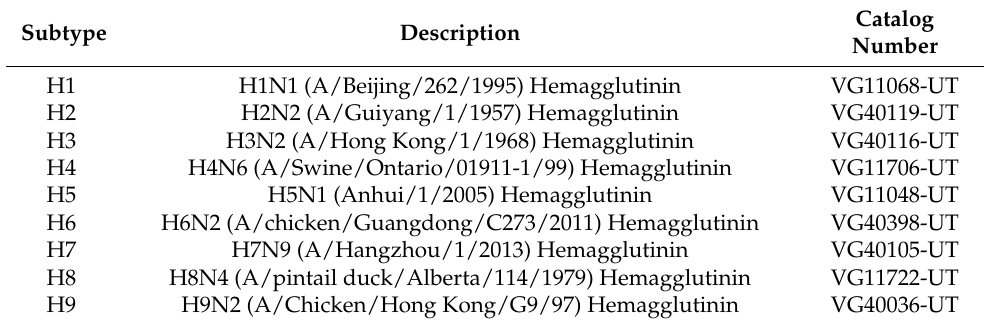
Table 2. Influenza virus template